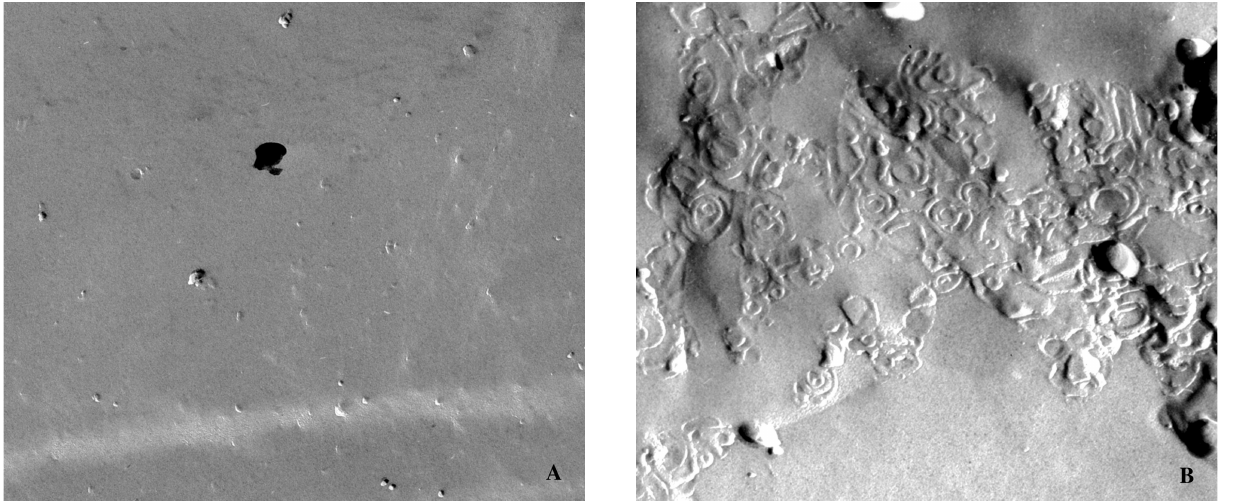
Figure 5. Electron micrographsof freeze-fracturereplicasof 500 µl of 0.4 mg ml –1 PLFE unilamellarvesiclesin 50 mM KCl. (A) Vesicleswithout Ca 2+ ; mean vesicle diameter ~84 nm. (B) Vesicles incubated with 15.1 mM Ca 2+ for 2 weeks. Magnification =